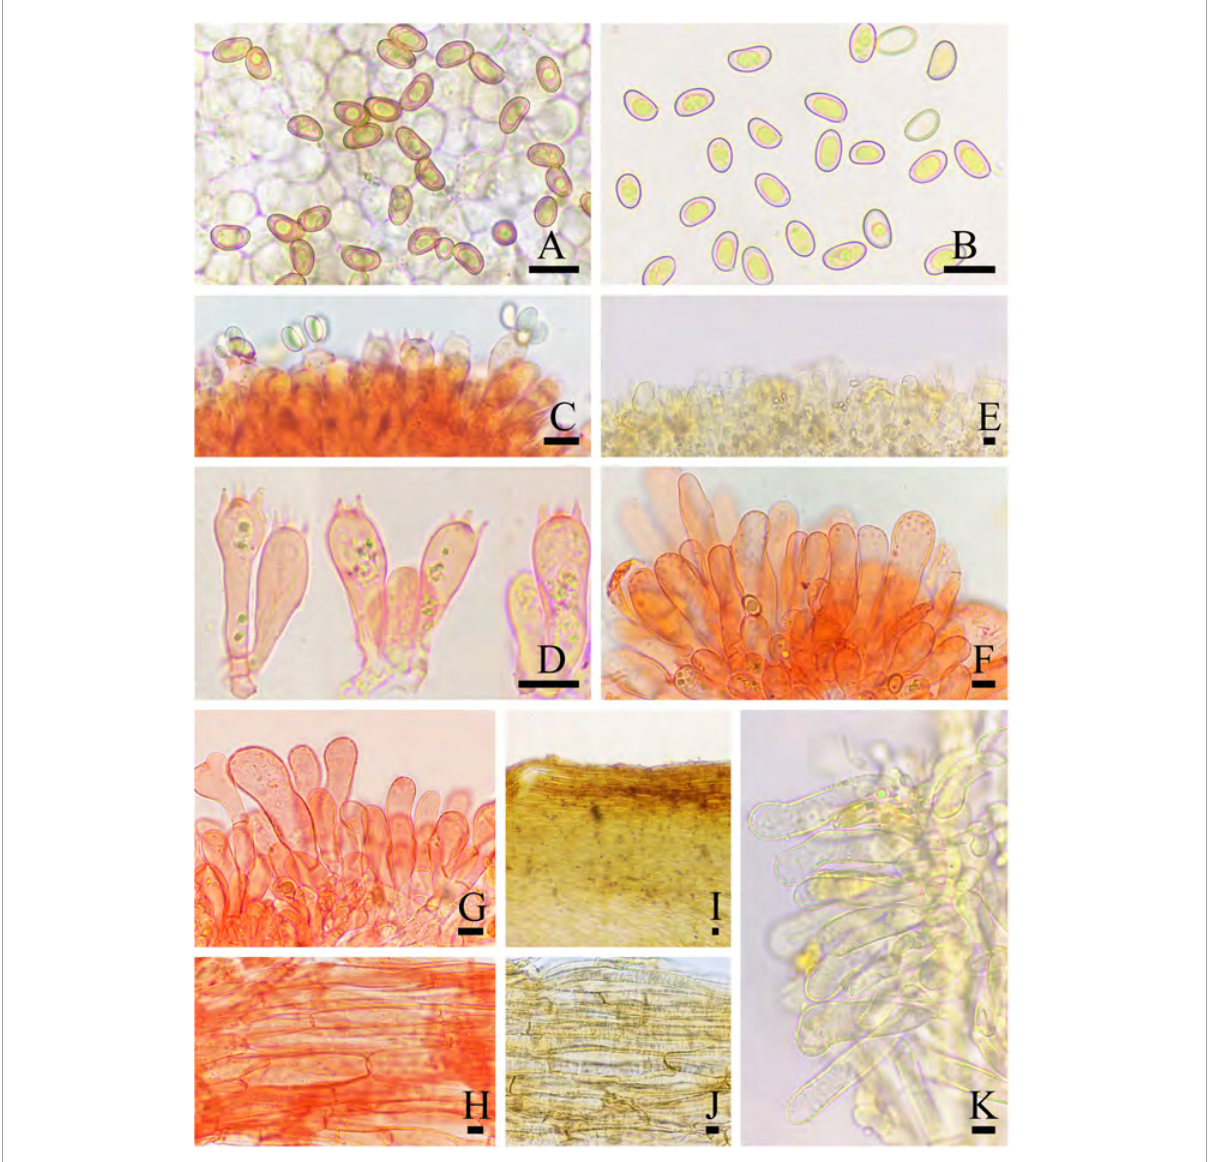
FIGURE5 Microscopic features of Inosperma sphaerobulbosum (MHHNU32266, holotype). (A,B) Basidiospores; (C,D) basidia with probasidium; (E) gill edge; (F,G) cheilocystidia; (H) hymenial hyphae; (I,J) pileipellis; and (K) caulocystidia. Scale bars = 10 µ m.